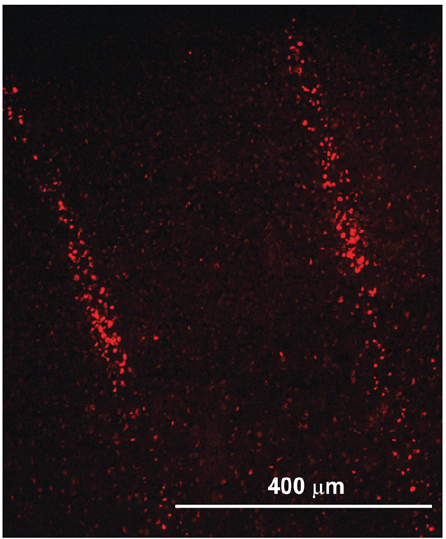
Figure 3. Immunohistochemistry of phosphorylated Gamma- H2AX in the cortex of an irradiated rat. Image shows the microbeam paths across the sensorimotor cortex of healthy rats: apoptotic neurons hit by microbeams (size: 100 m m, c-t-c 400 m m, incident dose 360 Gy) are evident.